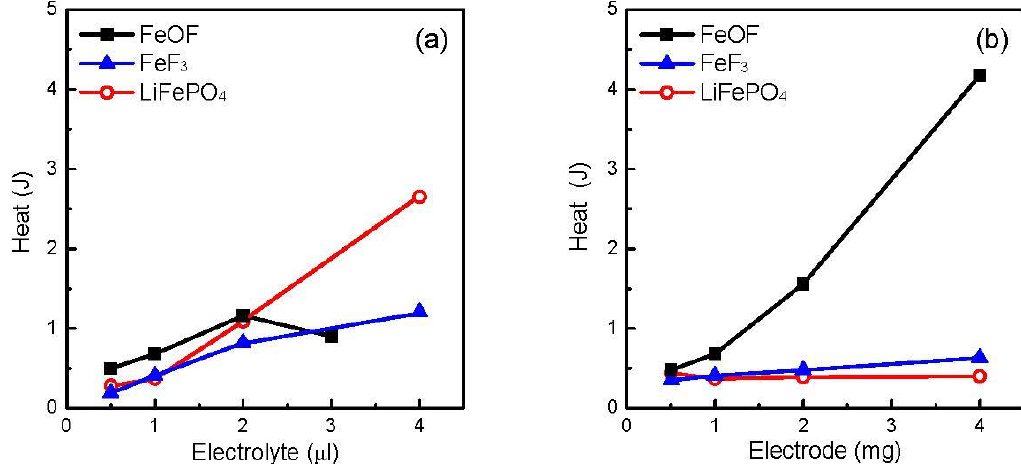
Figure 9. Comparison of the heat generation from a discharged FeOF cathode down to 0.7 V, a 3Li-lithiated FeF 3 cathode, and a charged LiFePO 4 cathode with the associated electrolytes. ( a ) Total heat generation of 1 mg cathode with various amounts of electrolytes; ( b ) Total heat generation of the various amounts of cathode with 1 μL electrolyte.